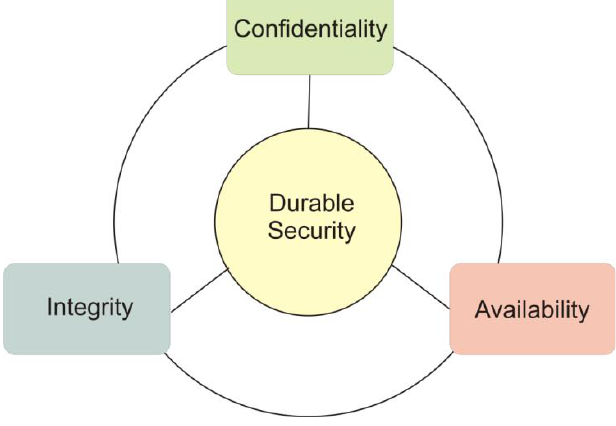
Figure 5. Durable security web for